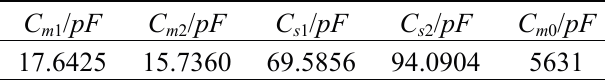
Table 1. Capacitance parameters of a single.